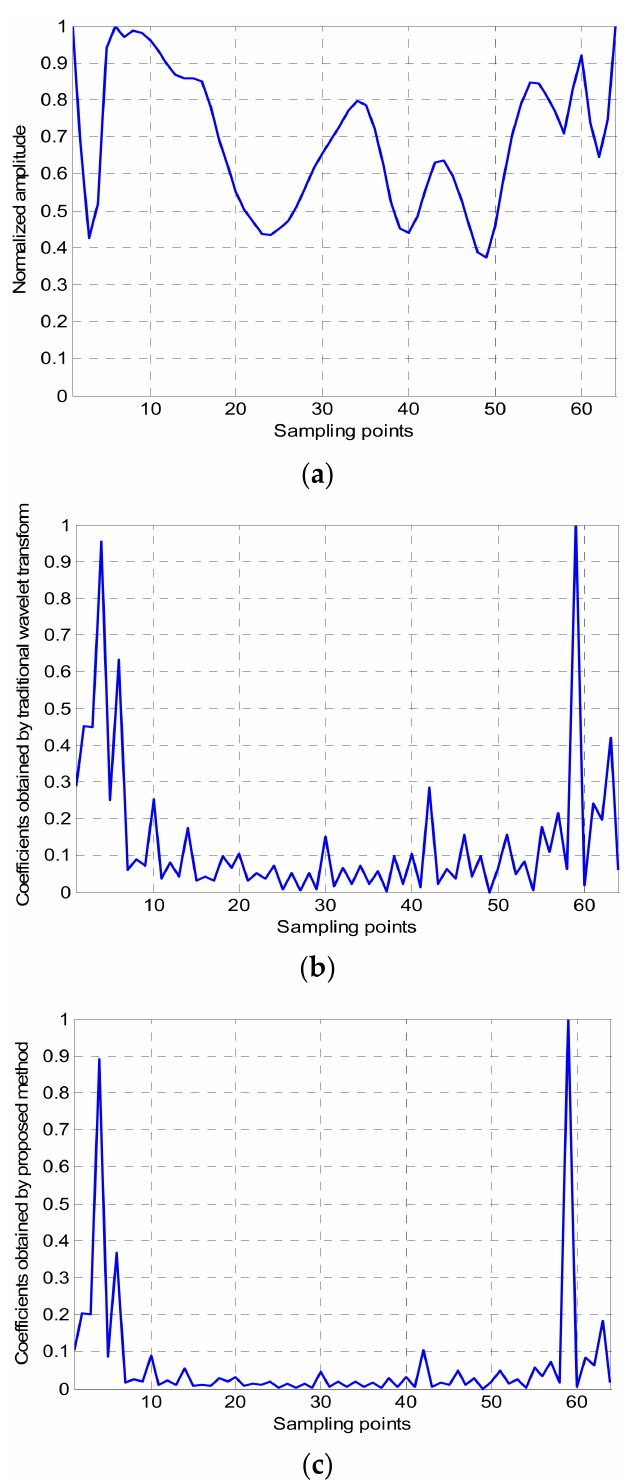
Figure 1. Comparison of the wavelet coefficients obtained by traditional wavelet transform and pro- posed method. ( a ) Original one-dimensional signal; ( b ) wavelet coefficients obtained by traditional wavelet transform; ( c ) wavelet coefficients obtained by proposed